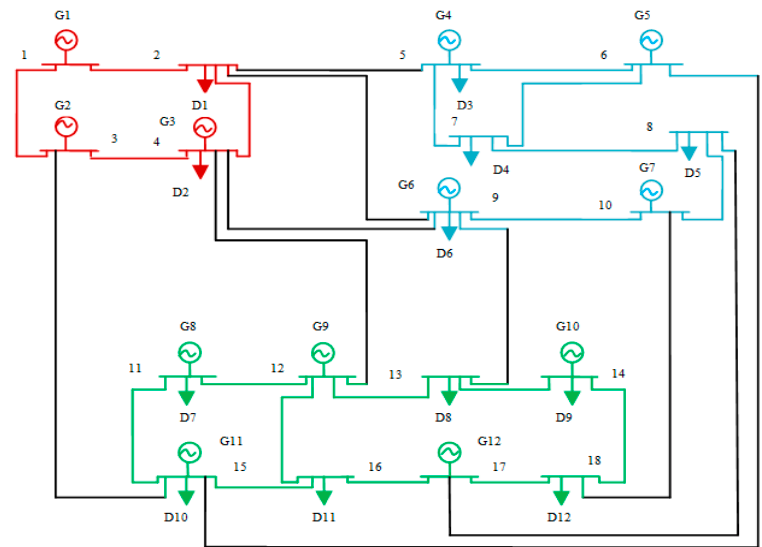
Figure 3. Eighteen-bus network.